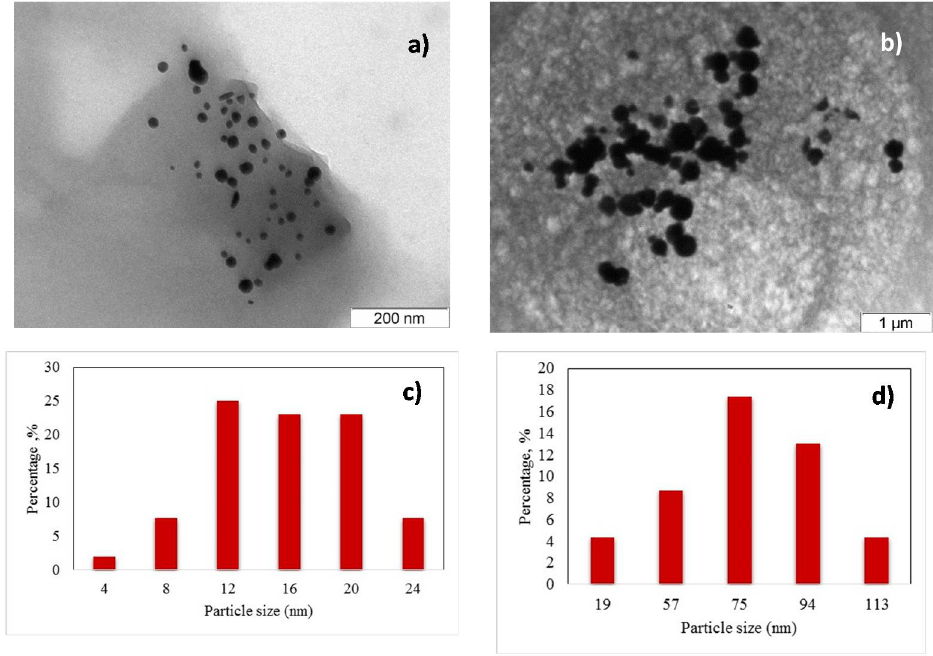
Figure 3. TEM images and size distribution of AuNPs 1% tea ( a , c ) and AuNPs 10% tea ( b , d ).